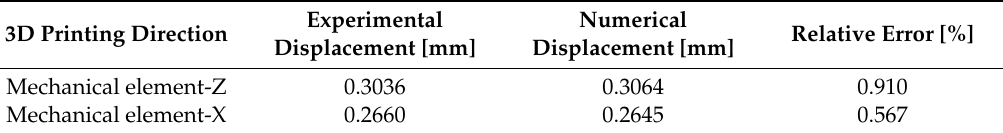
Table 12. Comparison of the experimental and numerical results obtained on the end part under the load scenario to which it is